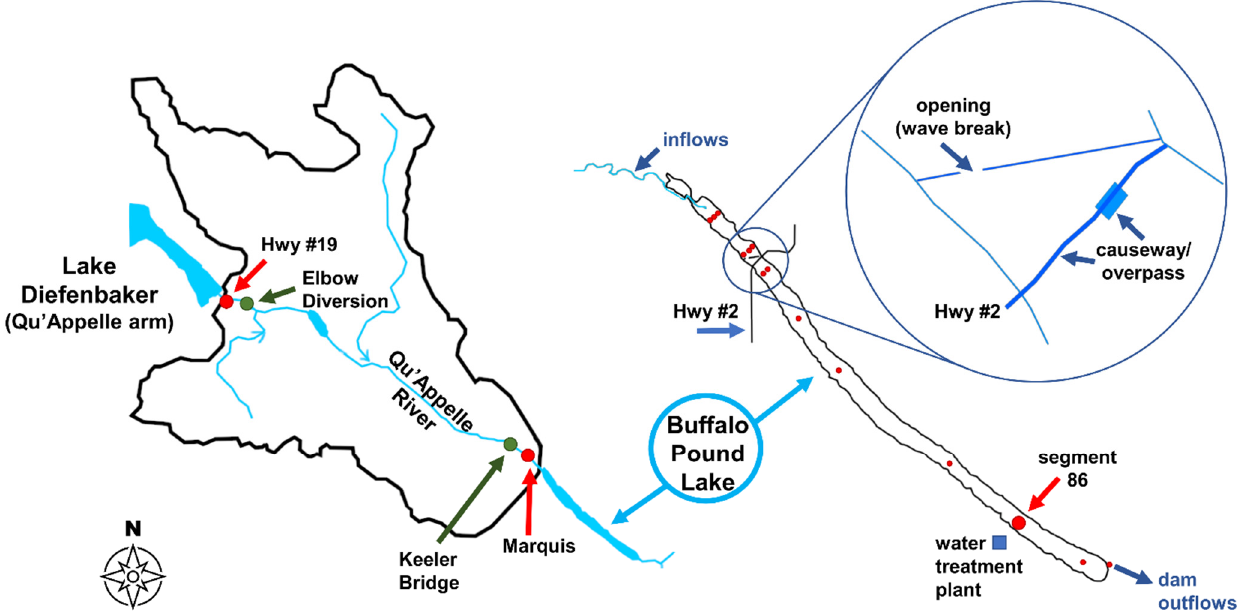
Figure 1. Left: The Upper Qu’Appelle watershed. Right: Buffalo Pound Lake (BPL), Saskatchewan, Canada. The lake has a mean depth of 3.8 m, maximum depth of 6.0 m, average width of 890 m, and total length of 30 kms. Red circles are the water quality sampling stations and green circles are the flow gauges used in this study. Hwy #2 and #19 are official highway numbers.